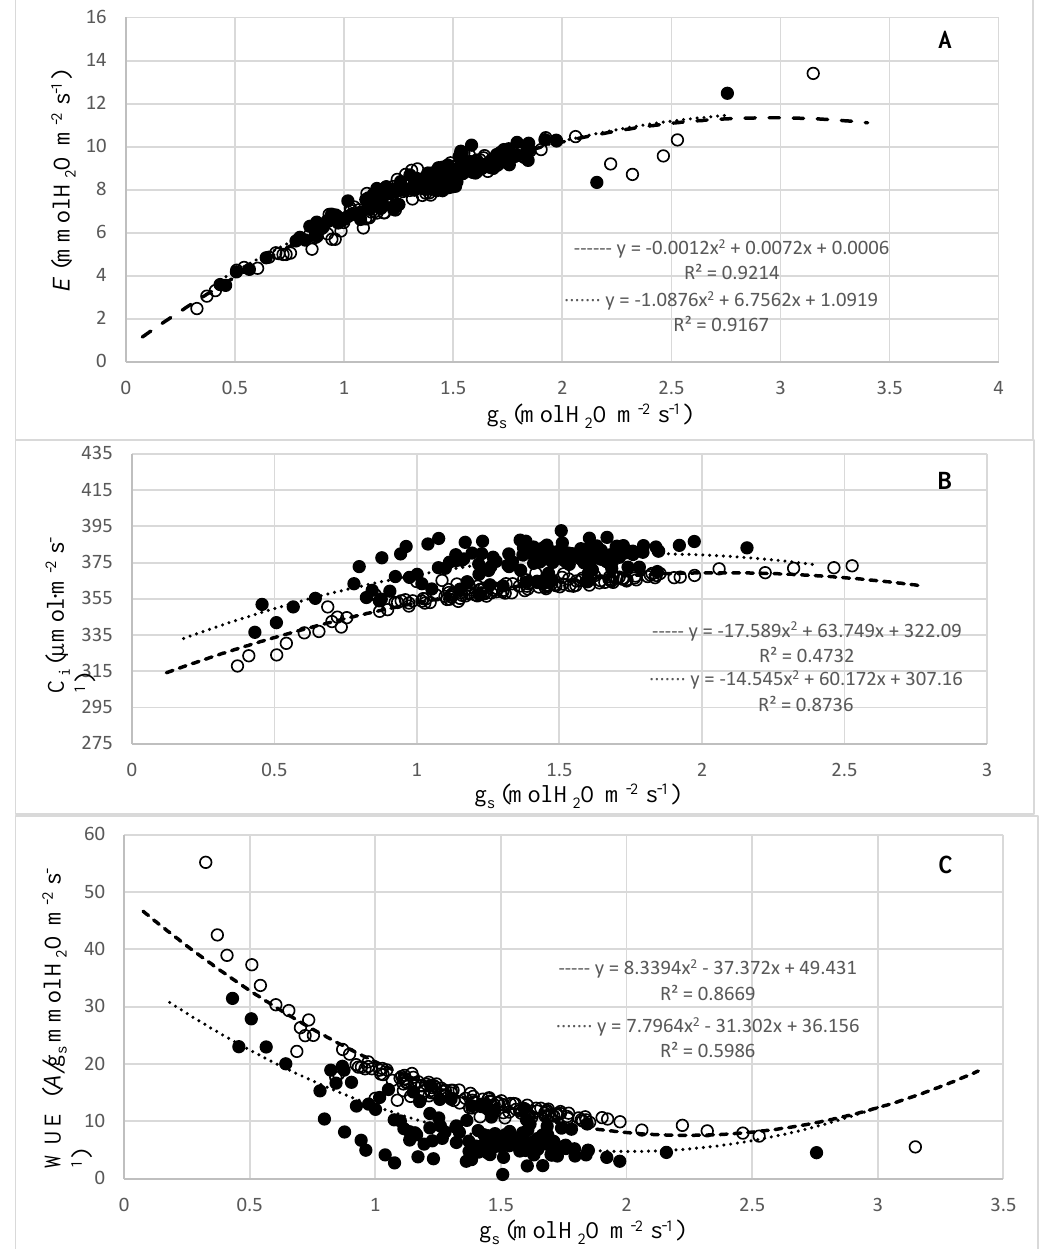
Figure 2. Relationship between stomatal conductance (g s ) and ( A ) transpiration ( E ), ( B ) internal CO 2 (C i ), and ( C ) water use e ffi ciency (WUE) in cucumber. Data is from 10-day treatments of waterlogging ( • ) or non-waterlogging ( ) treatments ( p ≤ (cid:35)